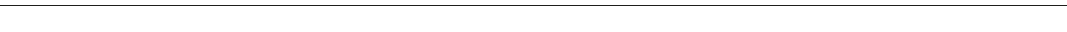
Fig. 4 Multiregion analysis of CNAs. a Multiregion CNA pro fi les of PCRCs. Chromosomal arm-level CNAs were called from the WES data of the ten PCRCs. Heat maps represent the presence of chromosomal arm-level CNAs (red, gain; blue, loss) for each case, and the shades of color are proportional to log 2 - scaled ratios between normalized tumor and normal read depths (log 2 R). PCRC10, in which no CNAs were detected, was omitted. Samples in each case are sorted in the same order as in Fig. 1. b, c Bar plots showing the number of ubiquitous and heterogeneous CNAs in each case of the PCRCs ( b ) and ACRCs ( c ). Effects of different number of samples between cases were corrected by downsampling (Methods). d Violin plots showing the distribution of the number of ubiquitous and heterogeneous CNAs based on b and c . ACRCs harbored a signi fi cantly larger number of ubiquitous CNAs than PCRCs ( P = 0.047; Wilcoxon rank-sum test), while the number of heterogeneous CNAs in ACRCs is comparable to that in PCRCs ( P = 0.16; Wilcoxon rank-sum test). e Bar plots showing the frequencies of ubiquitous (orange) and heterogeneous (green) CNAs for PCRCs and ACRCs. For ACRCs, CNAs were called from our previously published WES data of the eight non-hypermutated